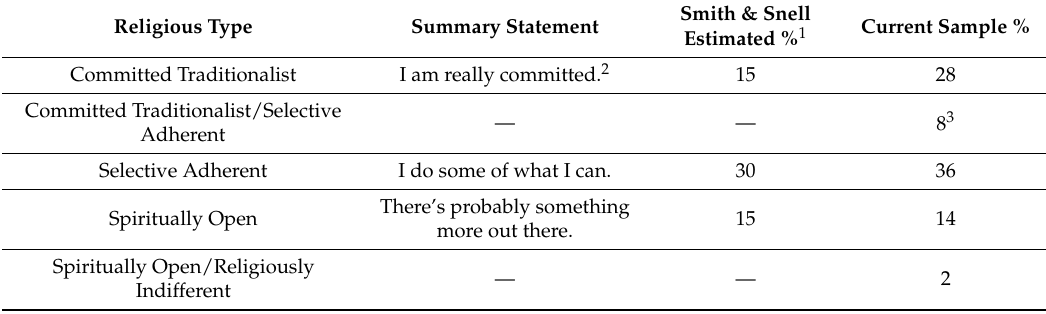
Table 1. Comparison of Frequency Distributions of Six Religious Types Across Independent